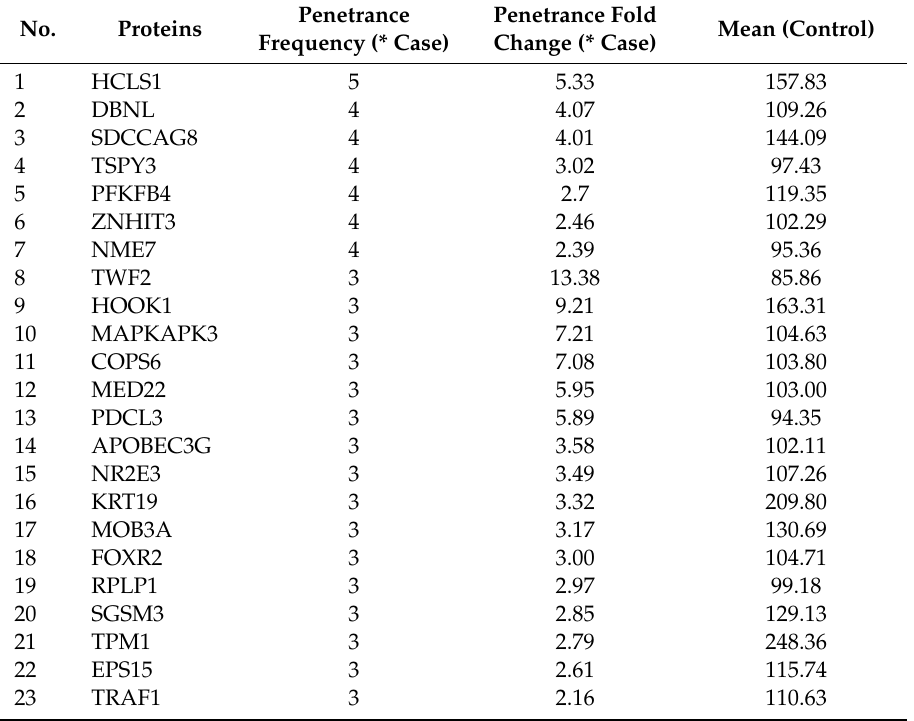
Table 2. A total of 23 biomarkers were identified in all cases (nine samples) in relative to healthy control (three samples). The biomarkers showed high autoantibody titers in all cases identified using the penetrance fold change-based